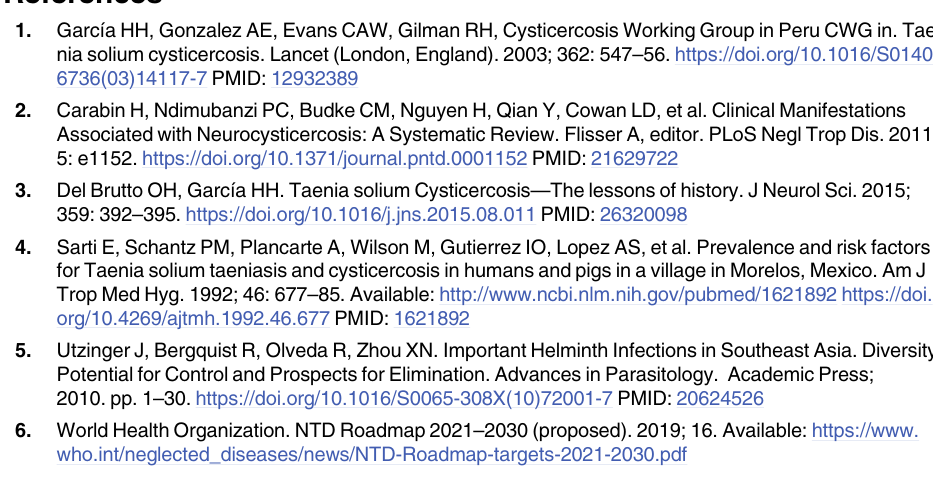
S2 Table. Studies focusing on testing effectiveness of control interventions. S3 Table. Studies focusing on implementation research for control interventions or scale-up of